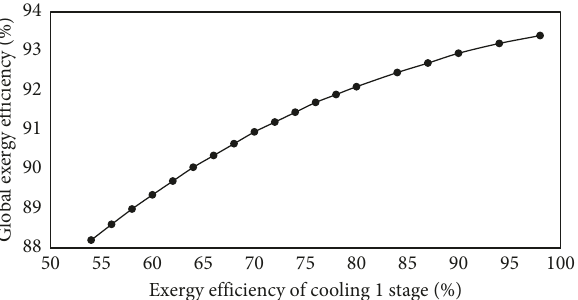
Figure 7: Effect of cooling 1 (HE-201-202) stage efficiency on global exergy efficiency.